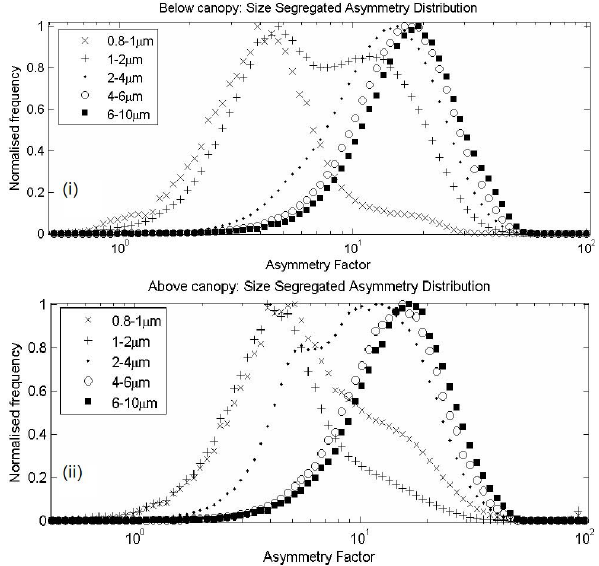
Fig. 12. Normalised Asymmetry Factor distributions (i) in the un- derstorey and (ii) above the canopy, segregated by particle size.